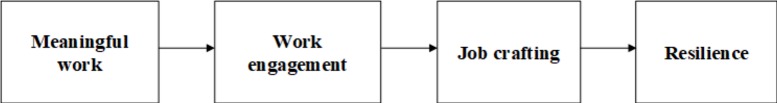
The proposed model.